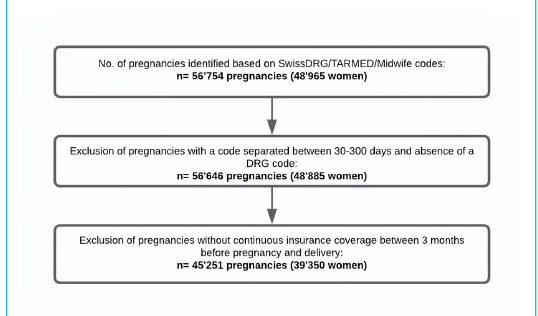
Figure 1: Flowchart of the study population (crude